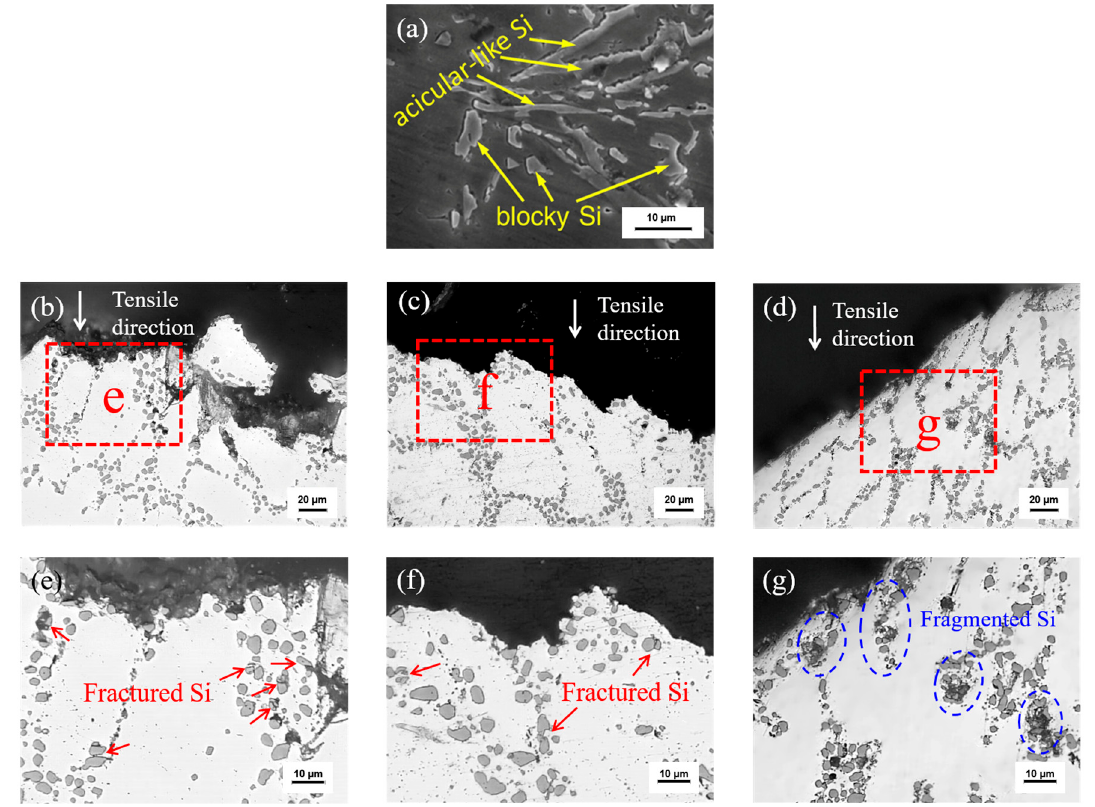
Figure 3. Fracture profiles microstructure of the untreated alloy ( a ) [1] and Sc-Sr composite modified alloy at different temperatures: ( b ) and ( e ) − 60 °C, ( c ) and ( f ) 20 °C, ( d ) and ( g ) 200 °C.